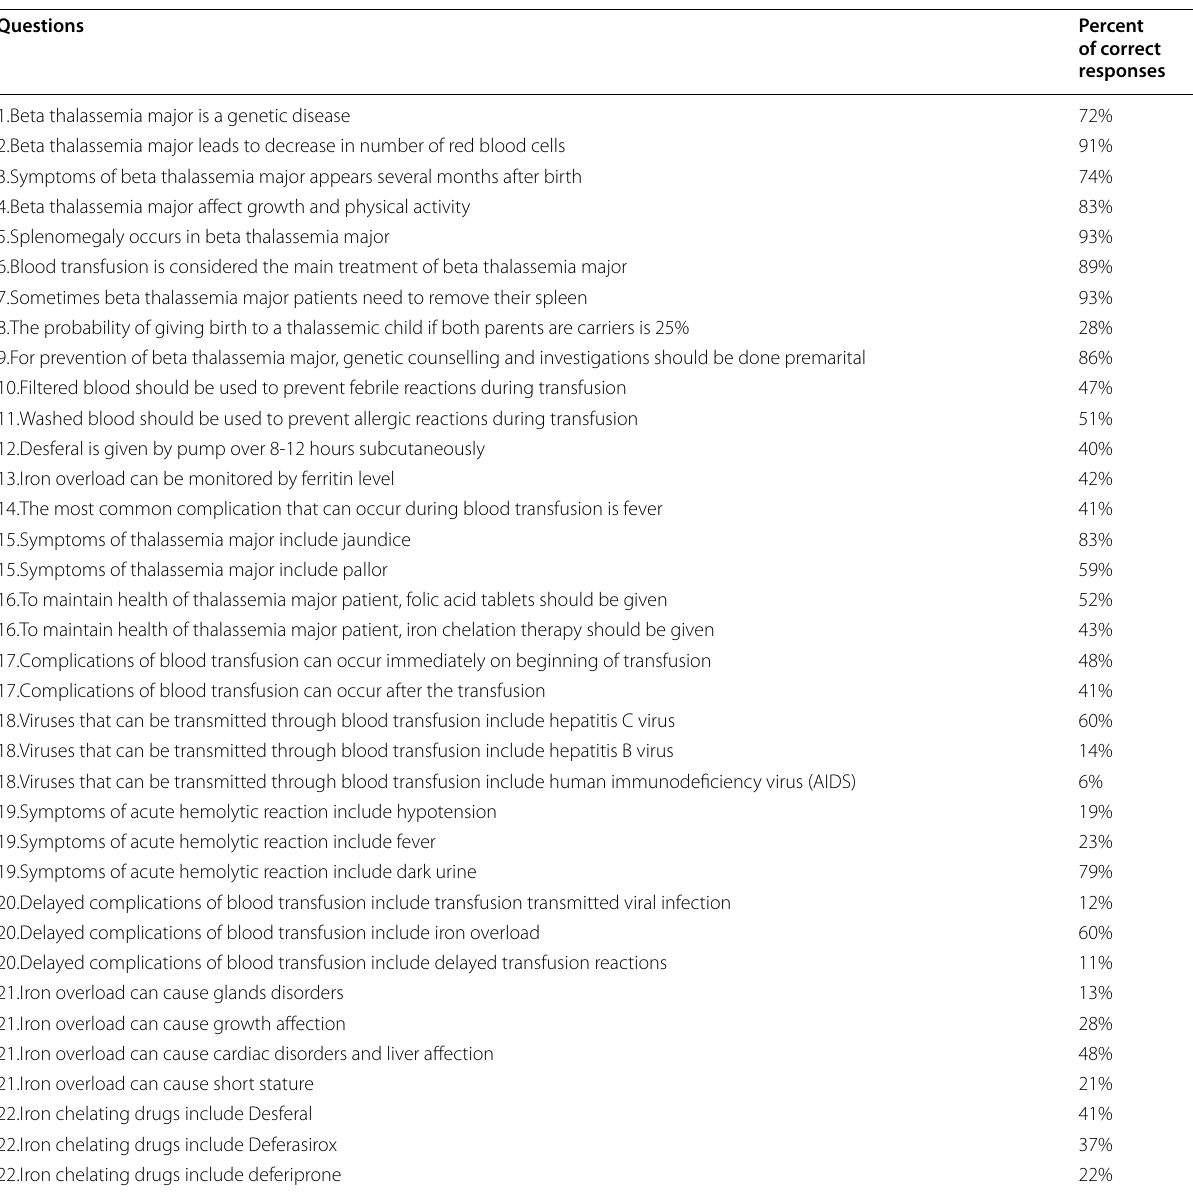
Table 2 Questions and percent of correct